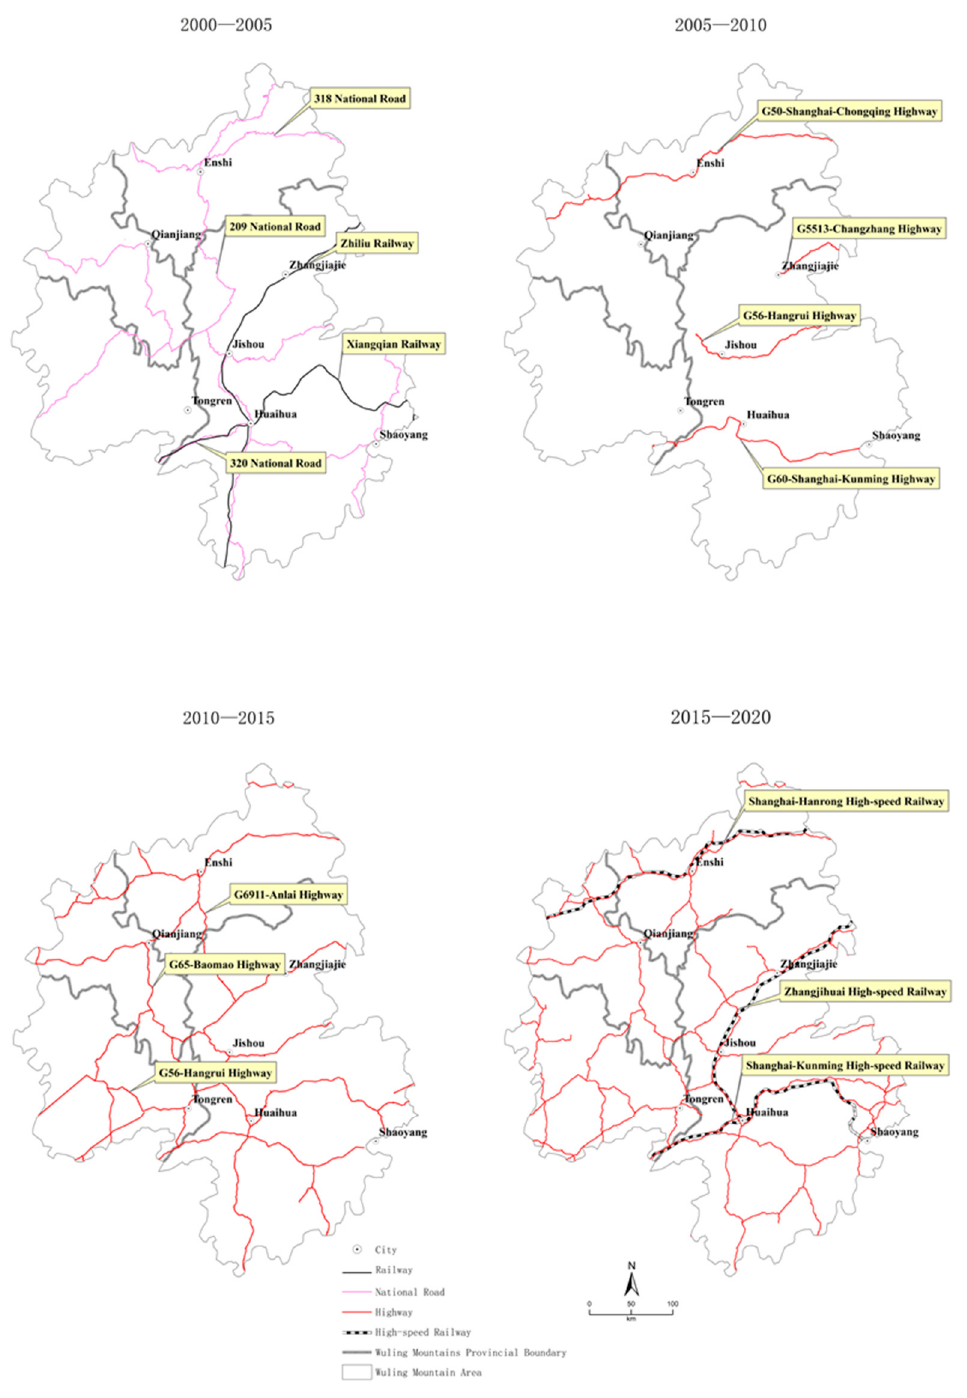
Figure 2. Map of the development of the transport pattern in the Wuling Mountains.